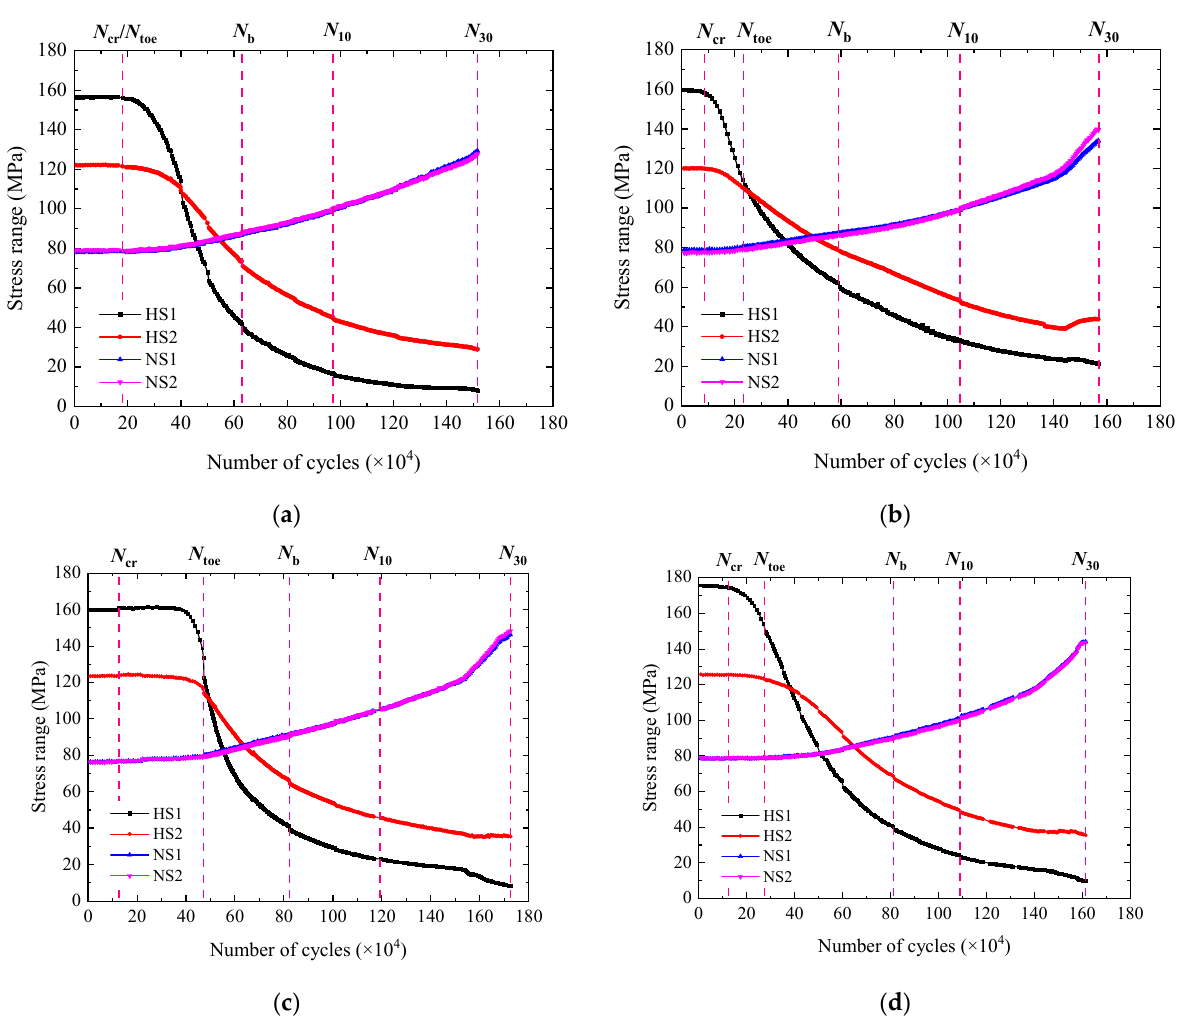
Figure 9. Variation of stress range with number of cycles for CS specimens. ( a ) C1-1. ( b ) C1-2. ( c ) C2-1. ( d ) C2-2.